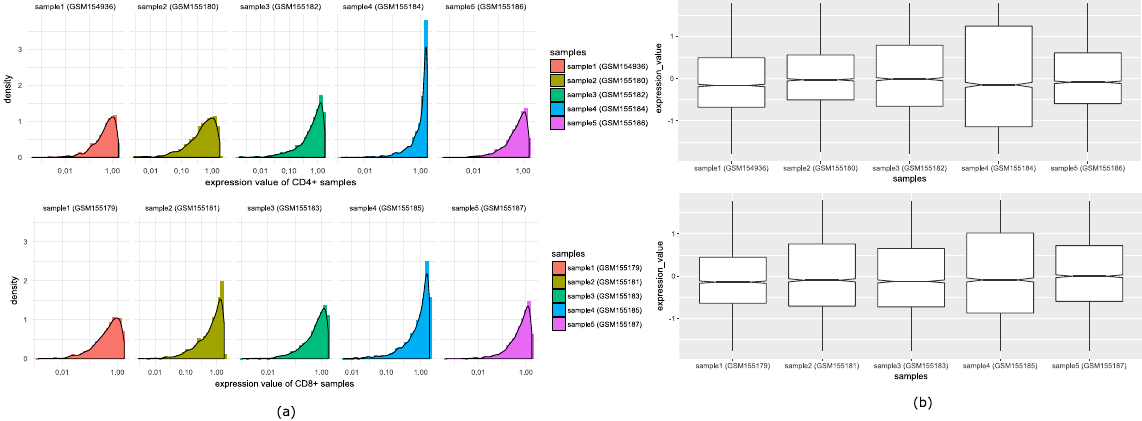
Figure 4. Comparison of expression values of CD4 + and CD8 + samples in acute stage. Panel (a) shows the distribution of five samples of CD4 + cell (GSM154936, GSM155180, GSM155182, GSM155184 and GSM155186) and five sample of CD8 + cell (GSM155179, GSM155181, GSM155183, GSM155185 and GSM155187). Panel (b) shows the boxplots of the corresponding samples.